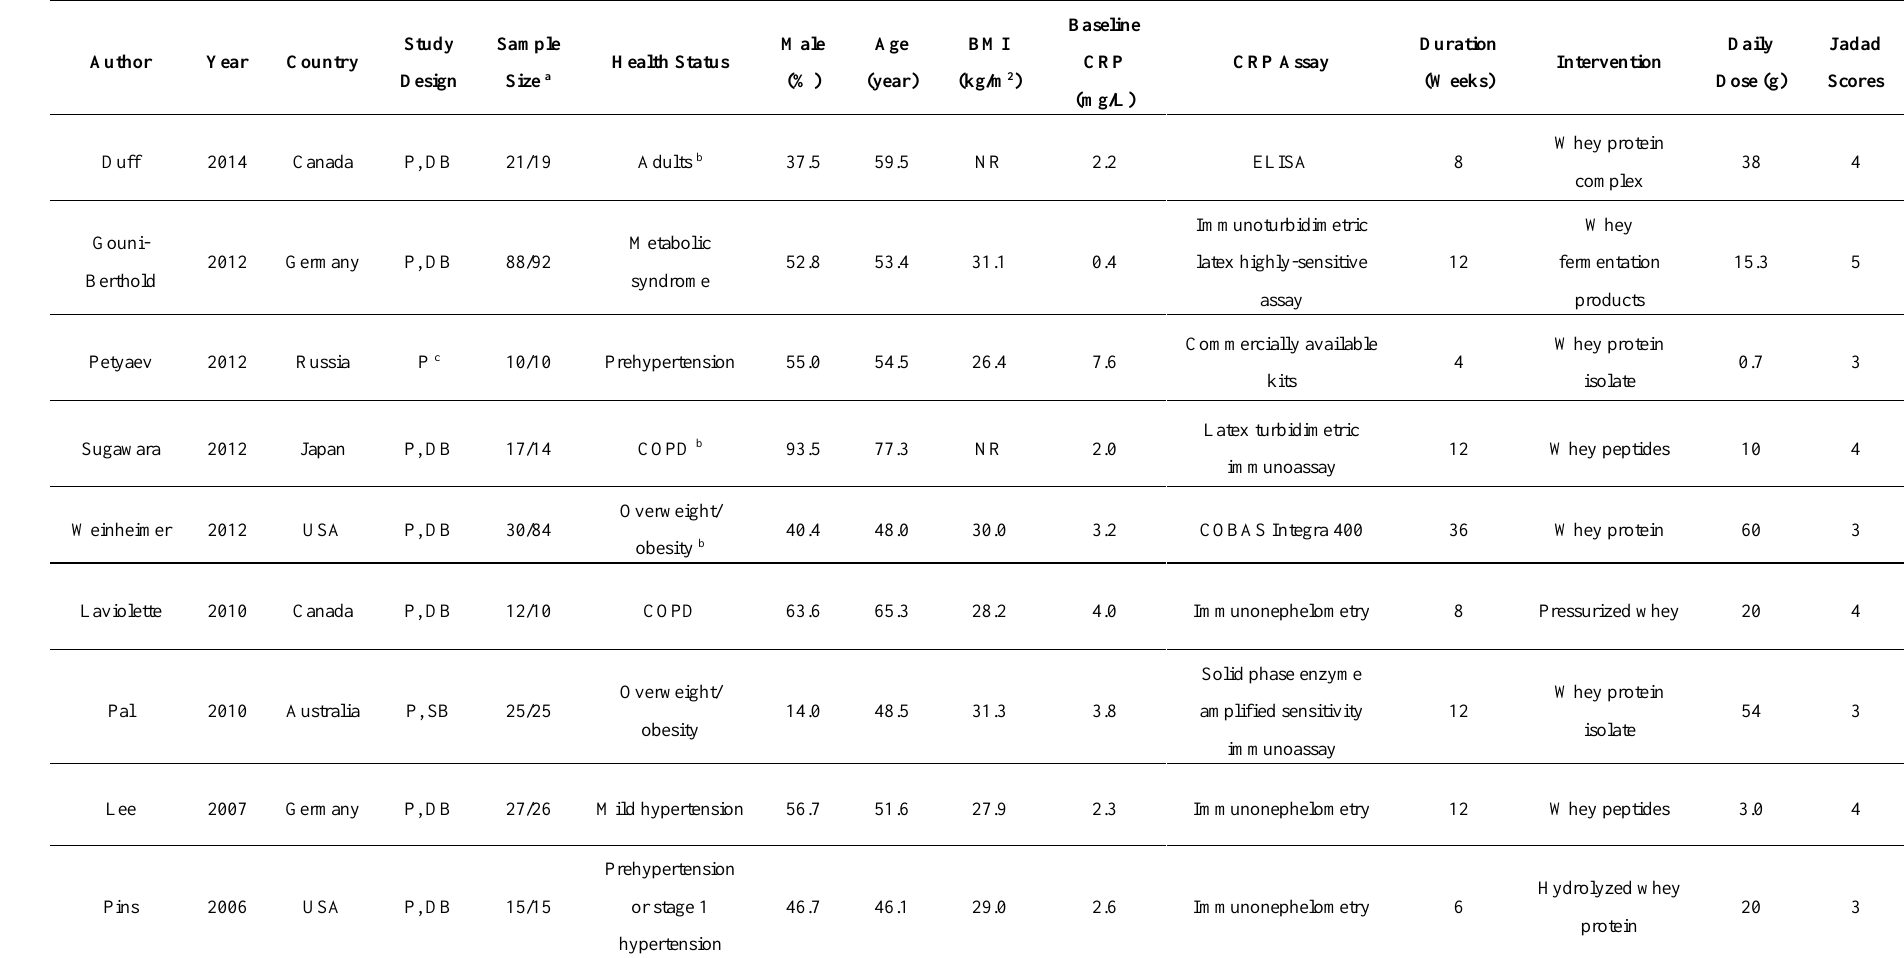
Table 1. Characteristic of the trials and participants in this